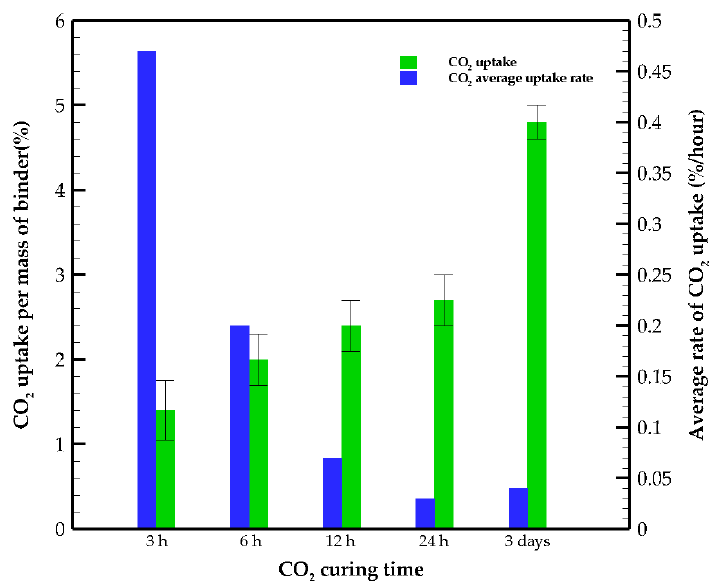
Figure 5. CO 2 uptake per mass of FA and its average rate with respect to curing time for specimens.